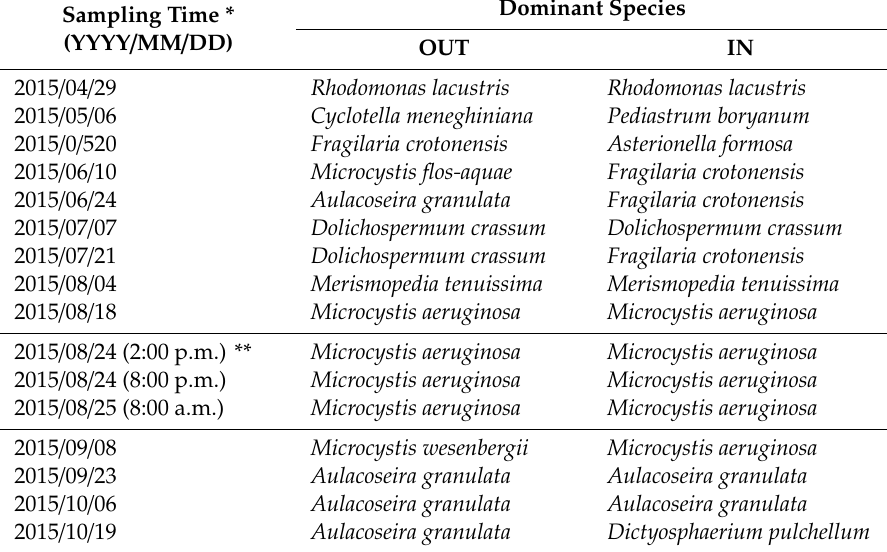
Figure 3. ( A ) Seasonal variation of total phytoplankton cell abundance and water temperature, and ( B ) precipitation and total phosphorus at the Paldangho intake facility from 29 April to 19 October 2015. Table 2. Dominant phytoplankton species on an alternative algae-blocking mat (ABM) during daily (24–25 August) and monthly monitoring between 29 April and 19 October 2015. OUT; reservoir water, IN; ABM-passed water.